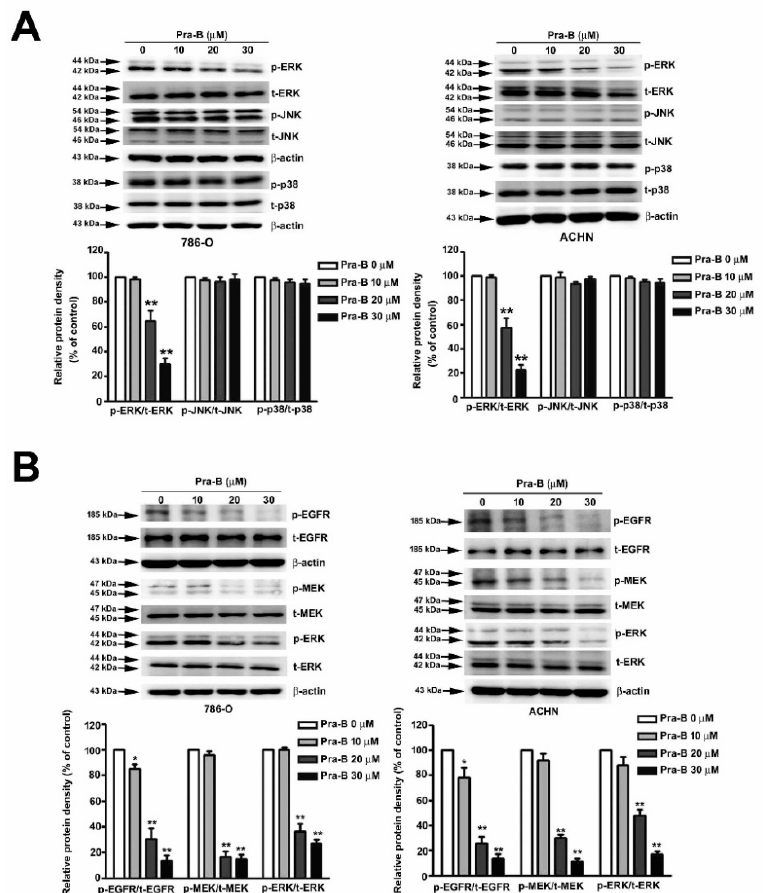
Figure 4. Pra-B suppressed epidermal growth factor receptor (EGFR)–MEK–ERK activation in 786-O and ACHN cells. ( A ) 786-O and ACHN cells were treated with various concentrations of Pra-B (0, 10, 20, and 30 µ M) for 24 h, after which the cells were harvested to detect MAPKs-related proteins (p-ERK, t-ERK, p-JNK, t-JNK, p-p38, t-p38) and ( B ) the p-EGFR, t-EGFR, p-MEK, t-MEK, p-ERK, t-ERK protein expression levels through immunoblotting. The histogram represents the densitometric analysis of protein expression. β -actin was used as the loading control. * p < 0.05, ** p < 0.01 relative to the control. Data are presented in terms of mean ± SD, as determined in at least three independent experiments.